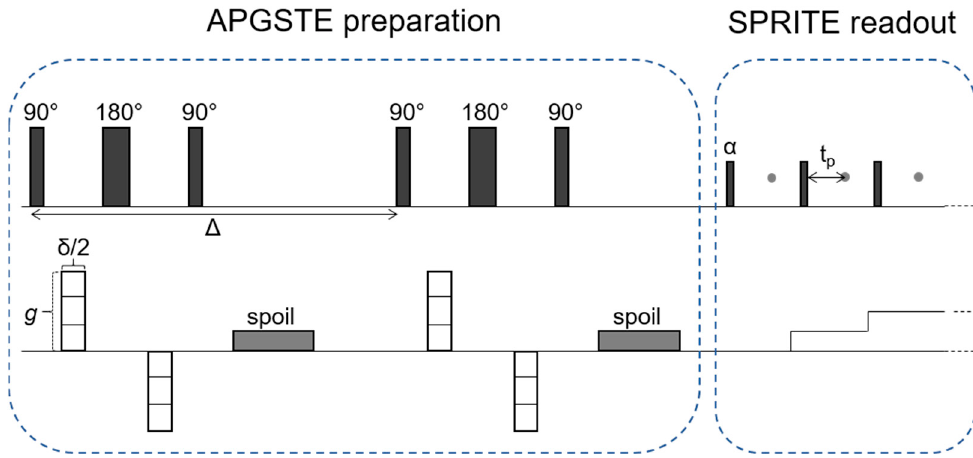
Figure 4. A schematic of the APGSTE-SPRITE pulse sequence [15]. Each individual SPRITE k-space measurement trajectory is preceded by an APGSTE preparation to ensure all measured data are motion sensitized. The parameters shown are as follows: g is the amplitude of the motion-sensitizing PFG, δ /2 is the duration of the PFG, ∆ is the flow evolution time, α is the flip angle of the imaging RF pulses in the SPRITE readout, and t p is the phase encoding time (the time between sample excitation and signal detection).